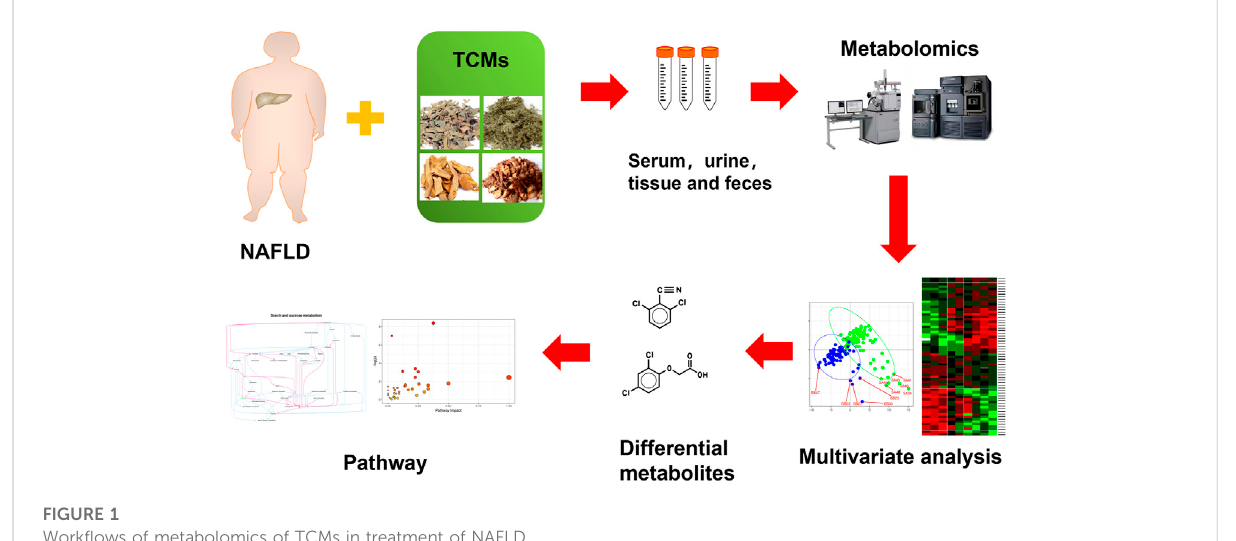
FIGURE 1 Work fl ows of metabolomics of TCMs in treatment of